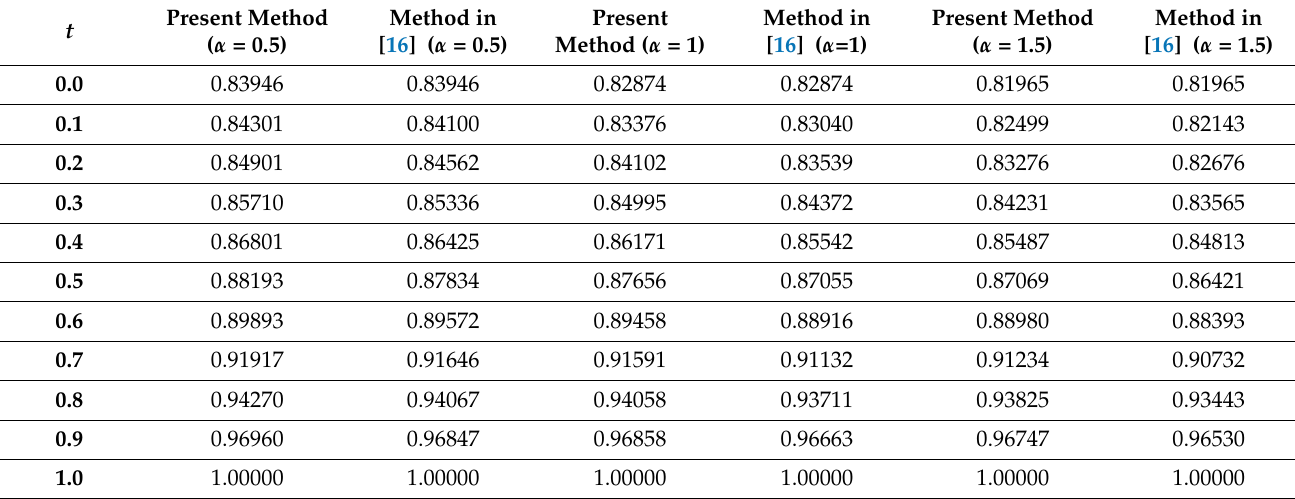
Figure 2. Effect of the Thiele modulus for different values of 𝜌 on the concentration 𝑣(𝑡; 𝛼, 𝜇, 𝜌) . Table 1. Comparison of the results with different values of the parameter α